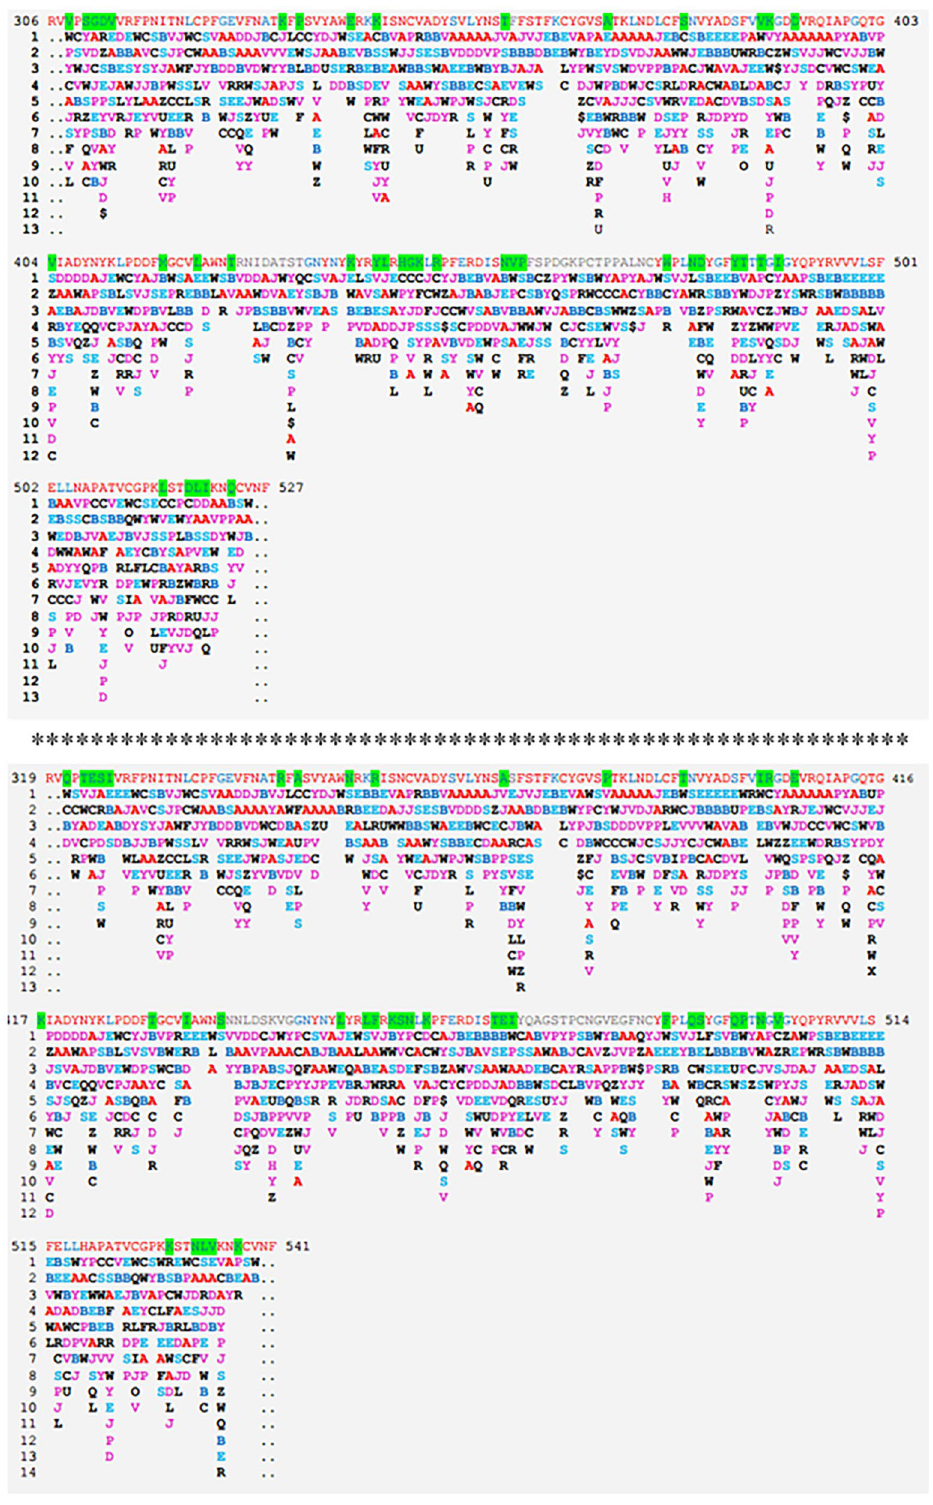
Table 4. The protein folding variation matrix (PFVM). The PFVM on top was obtained according to the sequence for PDB 6ACC-A-306–527 for SARS-CoV; the PFVM on bottom represents for PDB 6VSB-C-319–541 for SARS-CoV-2. On each PFVM, the sequence is horizontally listed above matrix, and the PFSC letters in each column represent the folding variations of continuous 5 amino acid residues with the most favored folding shapes are on top. The PFVM displays the folding variations along the sequence from N-terminus to